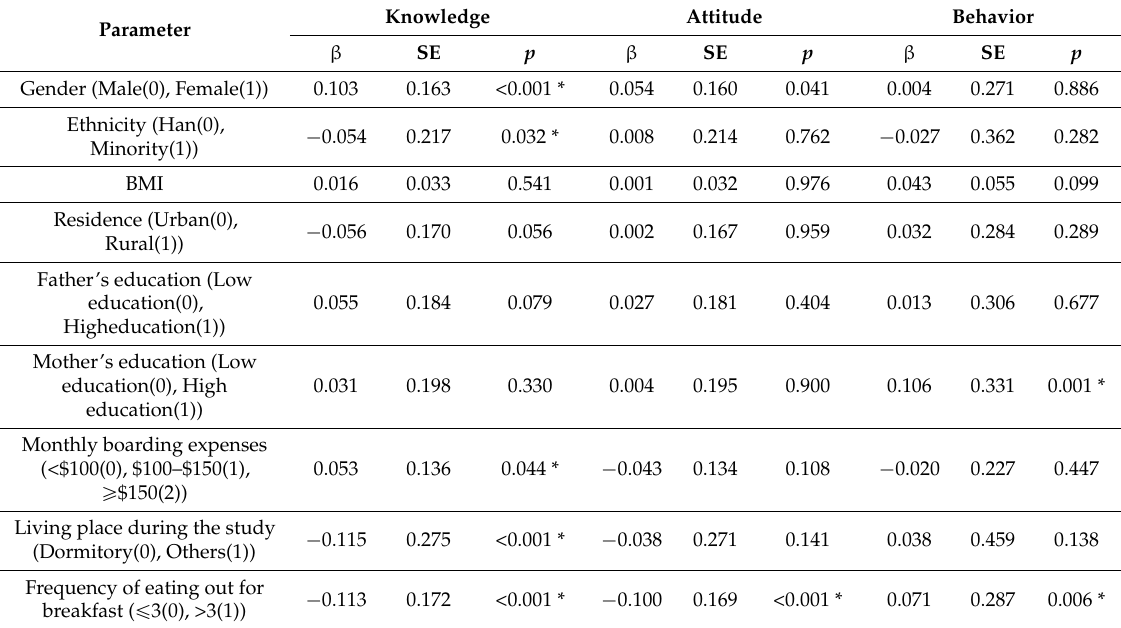
Table 4. Multiple linear regression analysis with background and